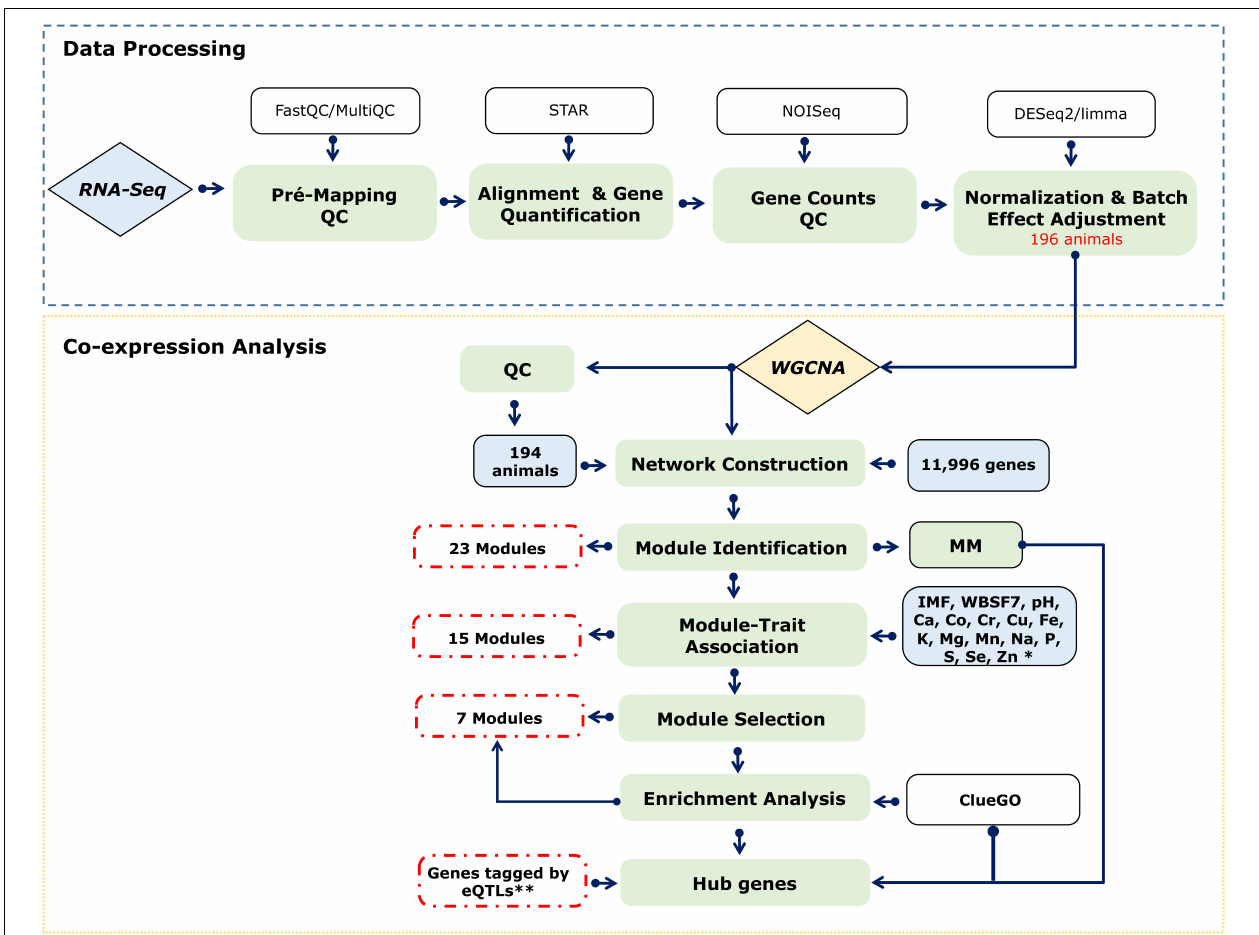
FIGURE 1 | Workflow. Green boxes represent the main analysis steps that were involved in data processing and co-expression analysis. Tools applied in each step are shown in white boxes. Inputs and outputs are shown in blue and dashed red boxes, respectively. ∗ A varying number of samples was analyzed for each trait ( Supplementary Table S1 ). ∗∗ Data from an eQTL analysis carried out for the same population used in this study (Cesar et al.,